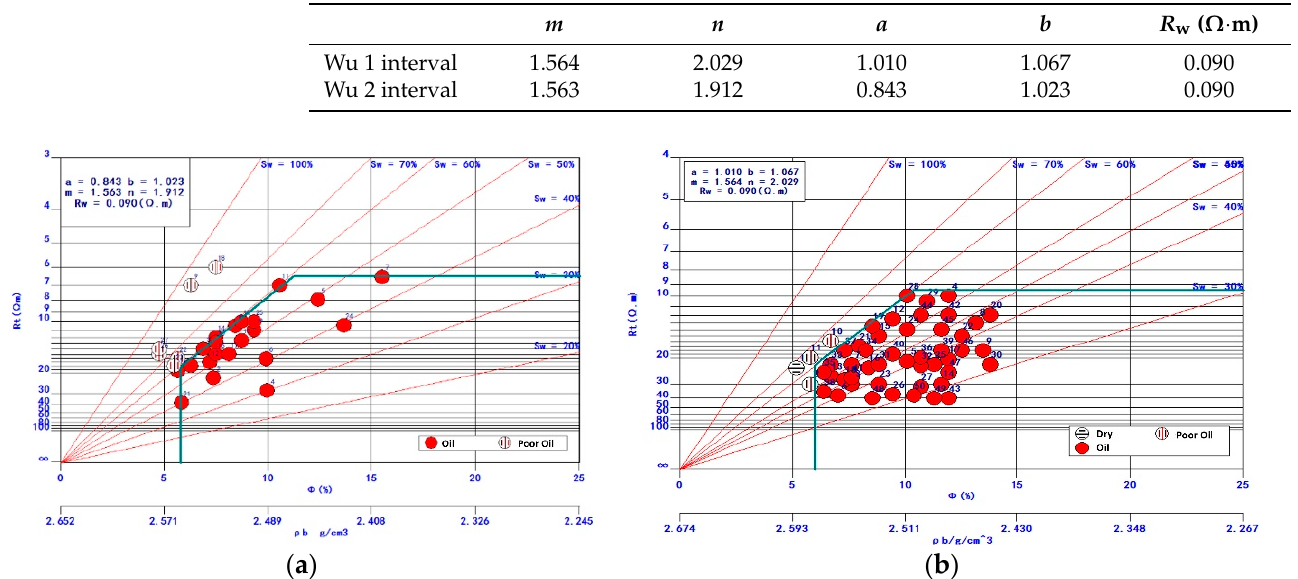
Figure 12. The resistivity—density, porosity crossplot: ( a ) P 3 w 2 layer; ( b ) P 3 w 1 layer. The thickness of the oil layer interpreted after correction is quite different from that of the originally interpretation for some wells. However, the interpretation results after correction are more consistent with the oil tests and reservoir understanding. The reservoir interpretation results of 7 out of 27 wells interpreted by the original logging curve are inconsistent with the oil test results. After correcting the logging curve, the reservoir interpretation of individual wells is clearer, and the logging interpretation is more consistent with the oil test results. For example, the production test conclusion of well XX046 shows that both P3w1 and P 3 w 2 are oil layers. The combined test of the P 3 w 2 layer obtained a daily oil production of 10.07 t/d and a cumulative oil production of 154.8 t; the combined test of the P 3 w 1 layer obtained a daily oil production of 0.92 t/d and a cumulative oil production of 66.14t/d. According to the current interpretation of the oil saturation, P 3 w 1 2 is an oil layer with 1 m thickness, P 3 w 2 is an oil layer with 14 m thickness, P 3 w 2 is an 2 1 oil layer with 5 m thickness, and P 3 w 3 is an oil layer with 8 m thickness. The original 1 logging interpretation interprets these two test intervals as dry layers. Well XX030 has conducted a combined test for the P 3 w 2 layer, with a daily oil production of 11.11 t/d and a cumulative oil production of 228.7 t. The combined test of the P 3 w 1 layer obtained a daily oil production of 1.4 t/d and a cumulative oil production of 37.5 t/d. The oil test results show that both P 3 w 2 and P 3 w 1 layers are oil layers. According to the current interpretation of the oil saturation, P 3 w 2 and P 3 w 3 are oil layers with 5 m thickness, and P 3 w 1 and P 3 w 2 2 2 1 1 are oil layers with 9 m thickness. However, the original logging interpretation results interpreted the P 3 w 1 test interval as a dry layer. After the curve correction, these oil testing layers can be correctly interpreted as oil layers. The original logging interpretation results and the current logging interpretation results are shown in Figure